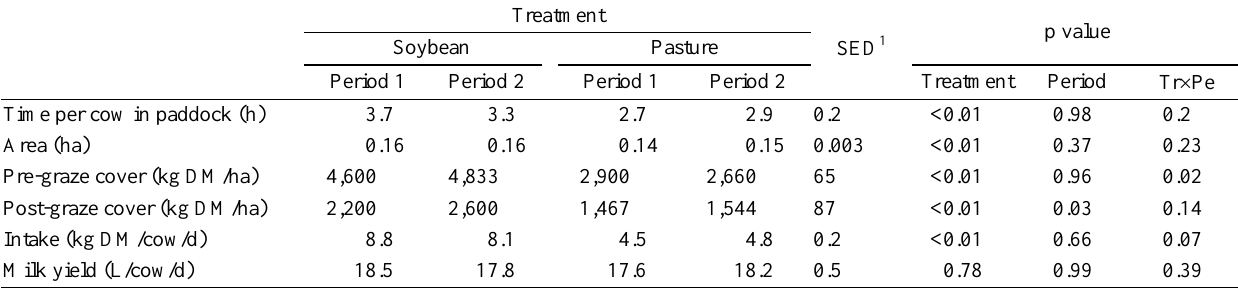
Treatment p value Soybean Pasture SED 1